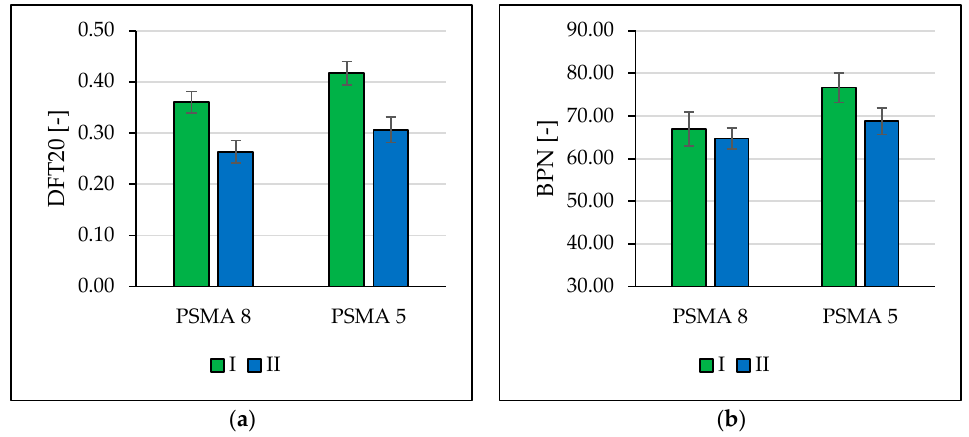
Figure 17. Comparison of the average values of DFT20 ( a ) and BPN ( b ) recorded in two measurement sessions.